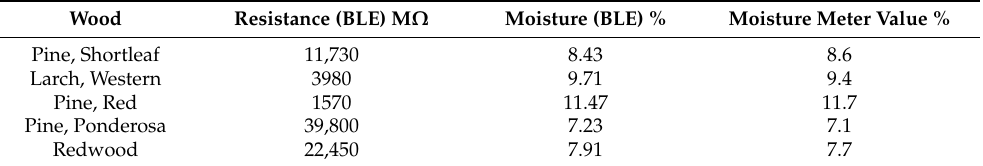
Table 4. Result of test with 5 different wood: Resistance BLE and Moisture BLE are the values transmitted from the device and Moisture meter value is the value read by the